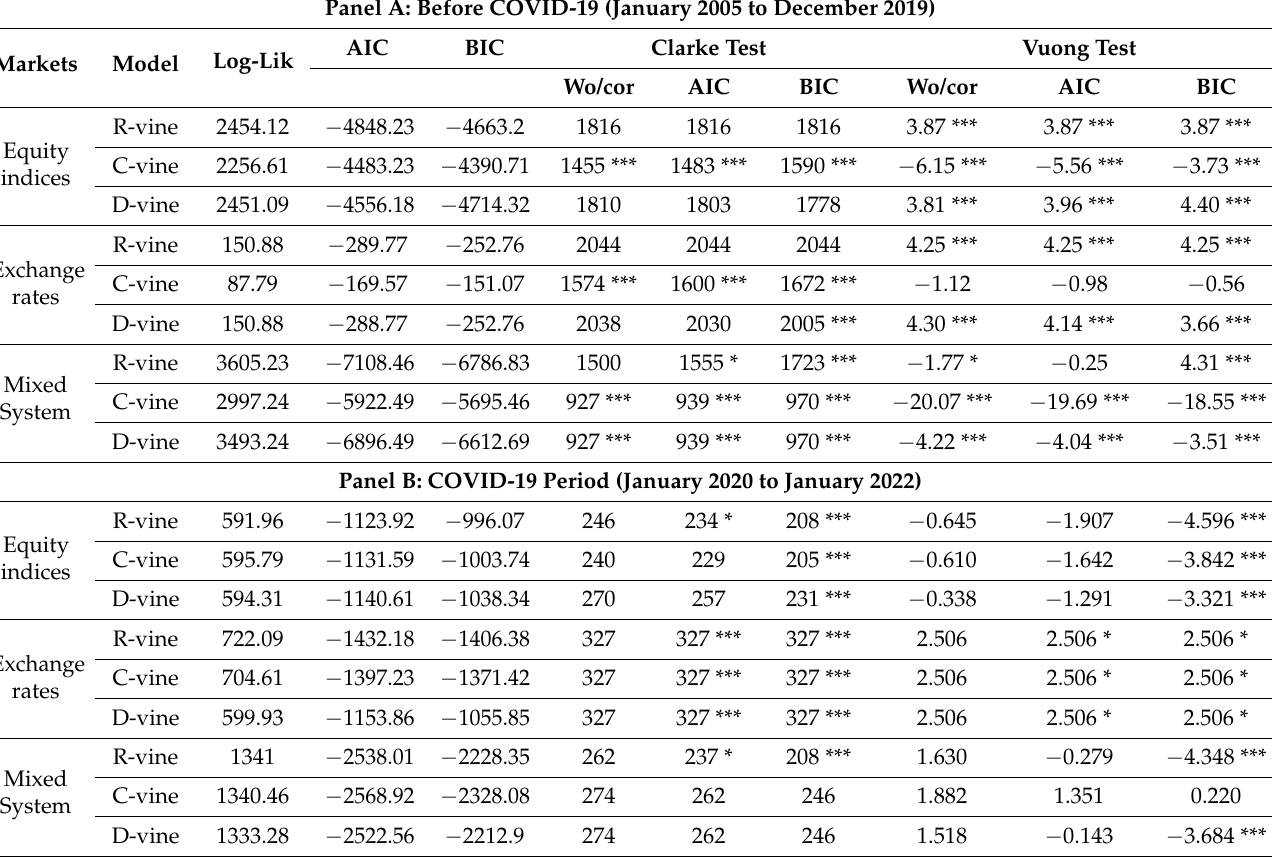
Table 3. Model assessment based on Vuong test for non-nested models. Panel A: Before COVID-19 (January 2005 to December